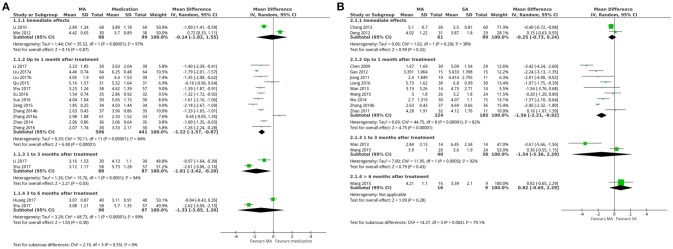
Forest plot: (A) acupuncture vs. medication- VAS Scores; (B) sham acupuncture- VAS scores. MA, manual acupuncture; SA, sham acupuncture.